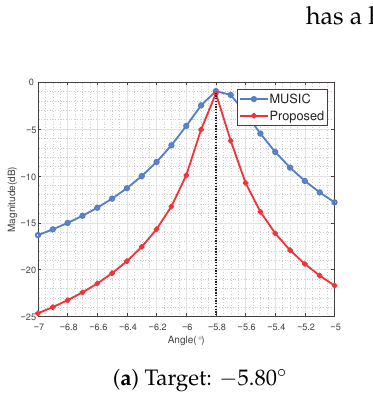
Figure 3. Partial view of the spatial spectrum of angle dimension